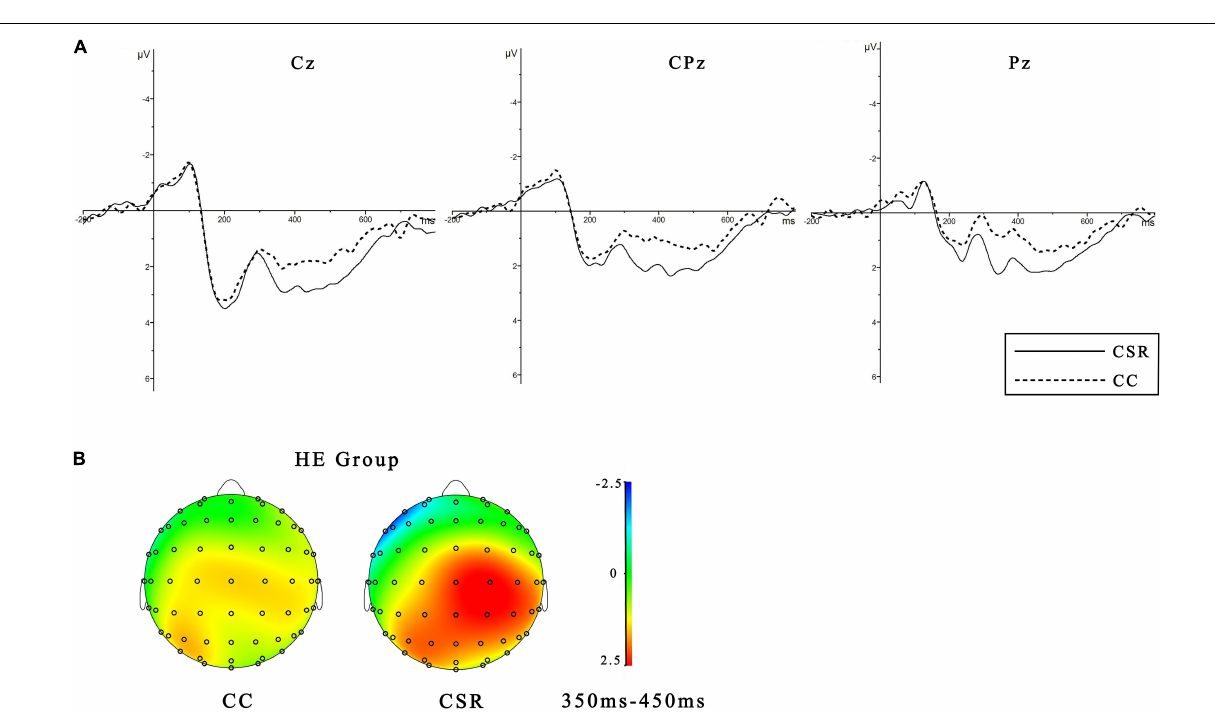
FIGURE 4 | Event-related potentials results. (A) Grand averaged waveforms of P3 for HE groups under the two conditions of CSR and CC associations at midline electrodes (Cz, CPz, and Pz). (B) The topographic maps for different conditions with the time window of 350–450